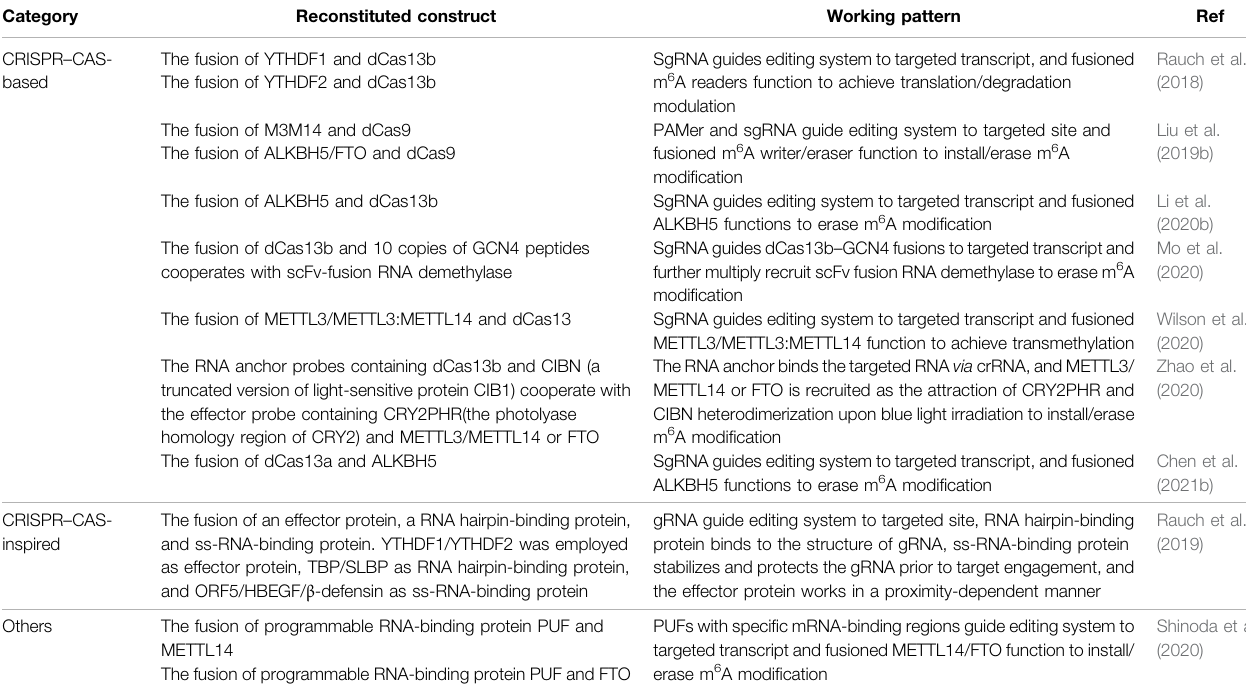
TABLE 1 | Novel tools for site-speci fi c m 6 A editing without primary sequence changed.